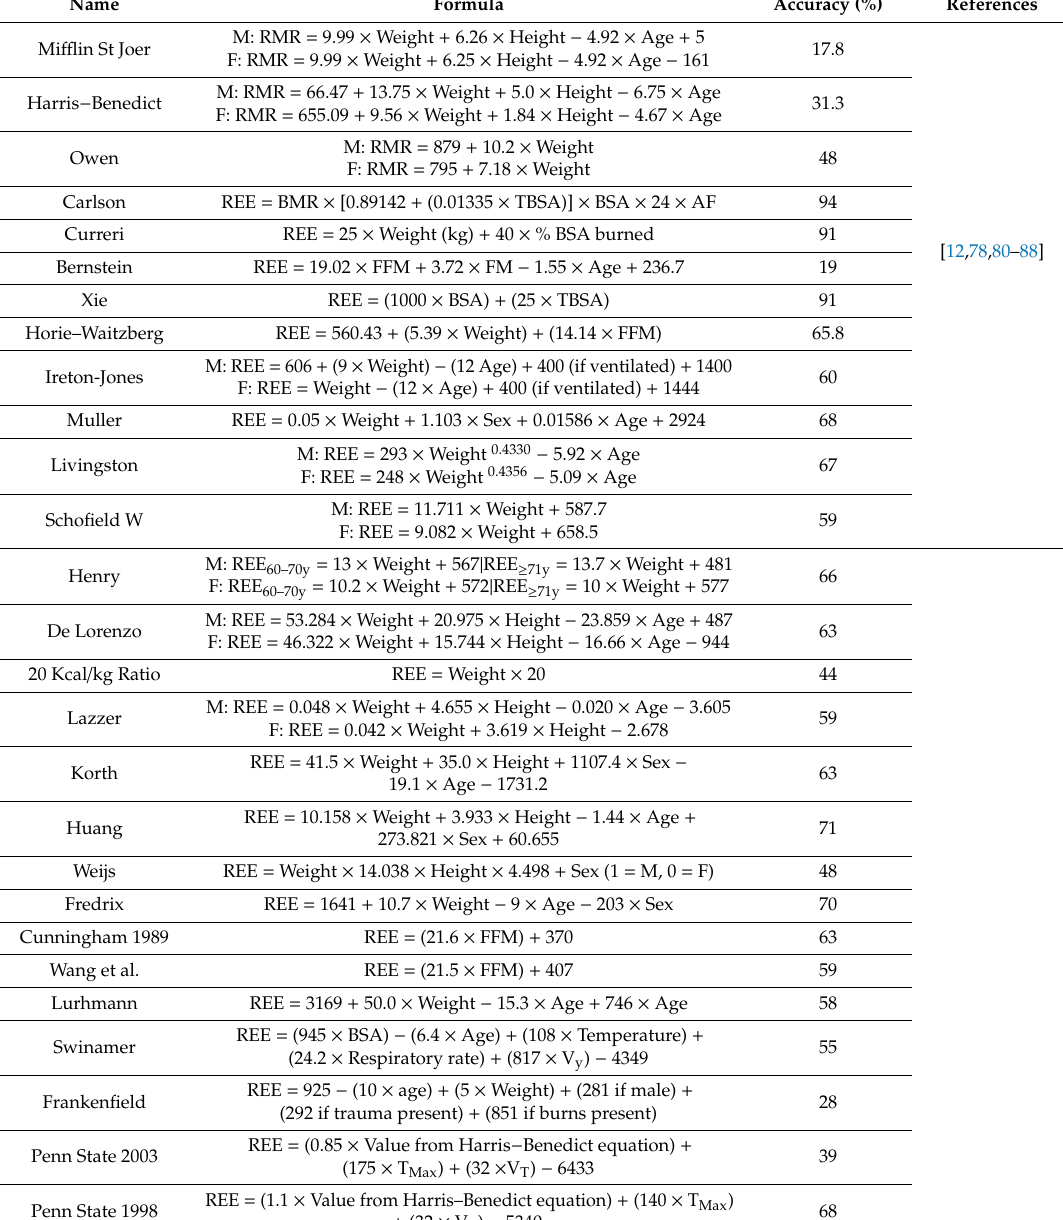
Table 1. Predictive equation for energy expenditure determination (M, male; F, female; RMR, resting metabolic rate; REE, resting energy expenditure; BMR, basal metabolic rate; FFM, fat free mass; FM, fat mass; TBSA, total body surface area; BSA, body surface area; and AF, activity factor, typically